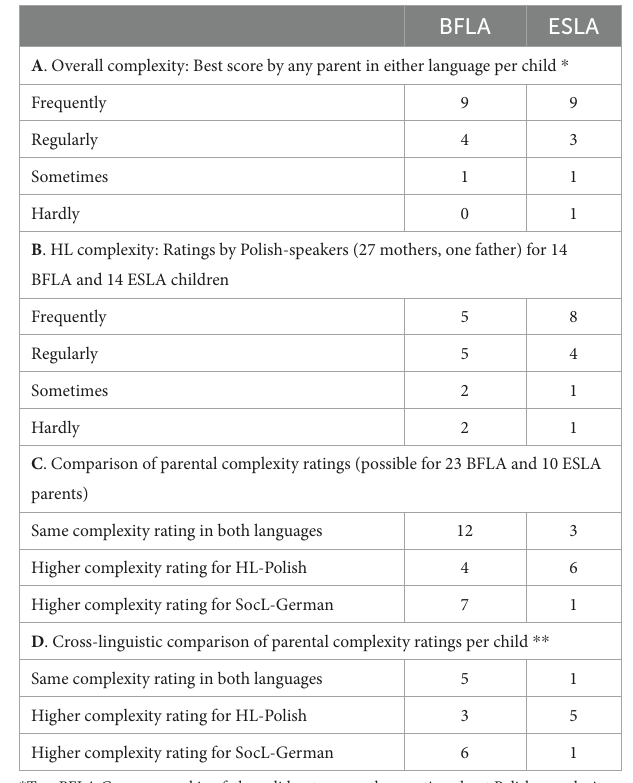
TABLE 5 Sample sentences in language complexity questions in